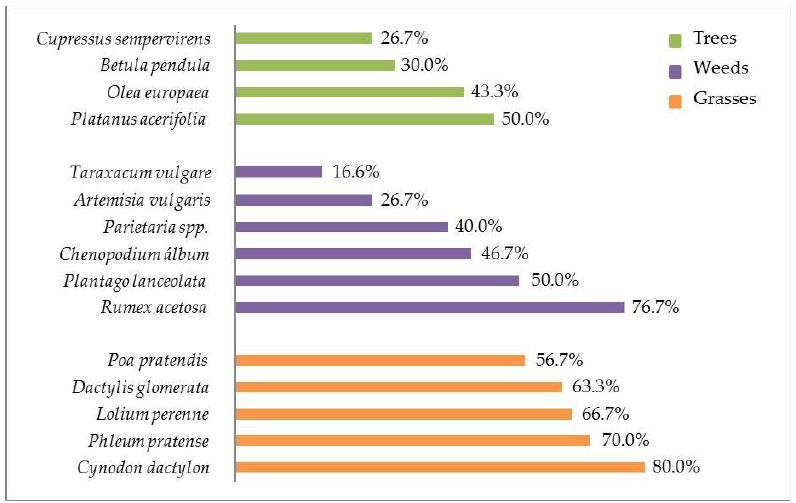
Figure 2. Distribution and percentage of various allergens in outdoor allergen panel (trees, weeds, and grasses) positive subjects ( n = 30) with canine atopic dermatitis.